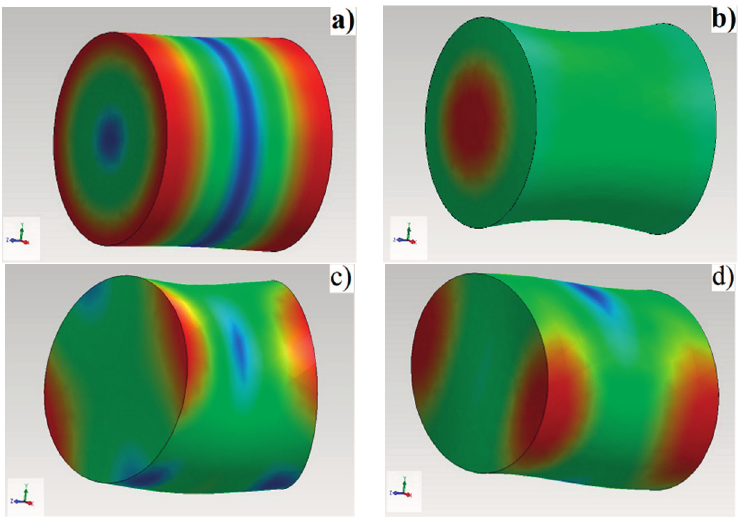
Figure 9. Resonant modes for sample π 2: ( a ) extensional mode, f = 163 kHz; ( b )